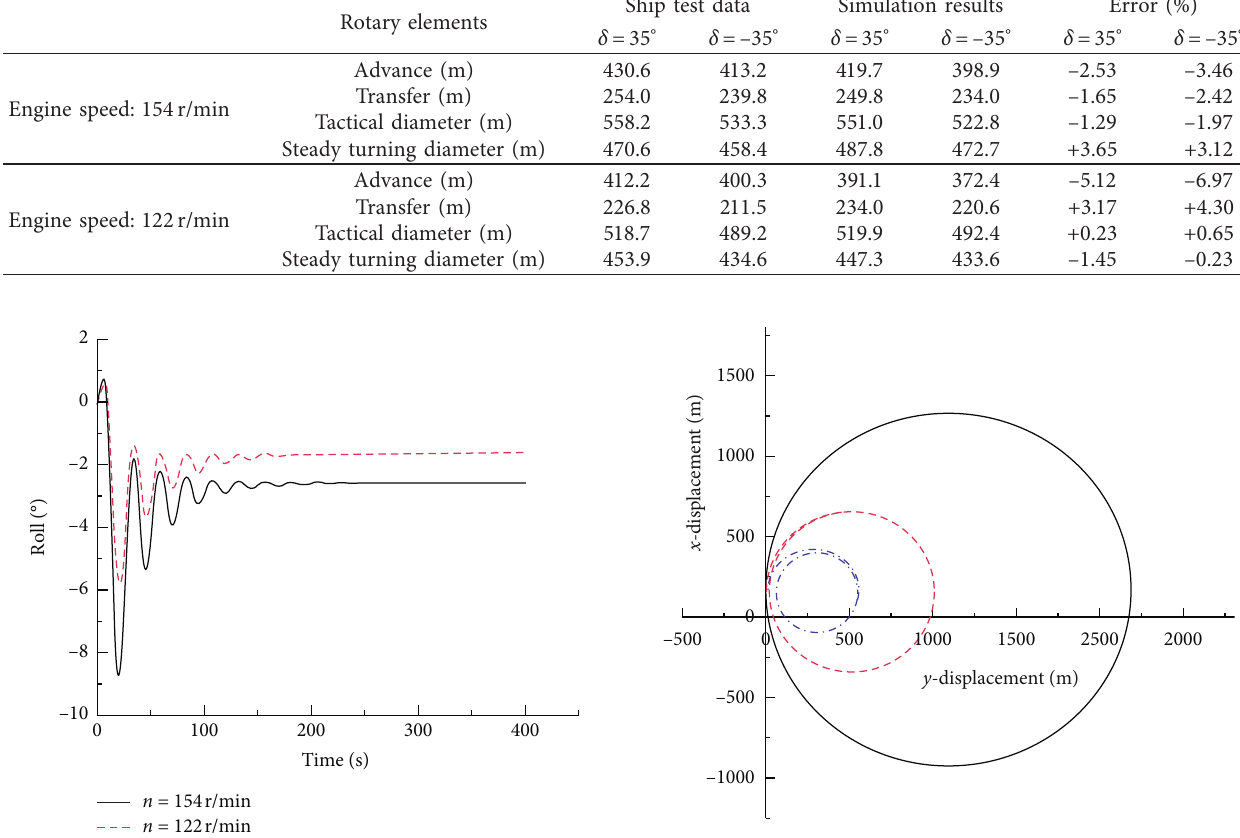
Figure 8: Roll angle for the ship’s starboard side at different main engine speeds.